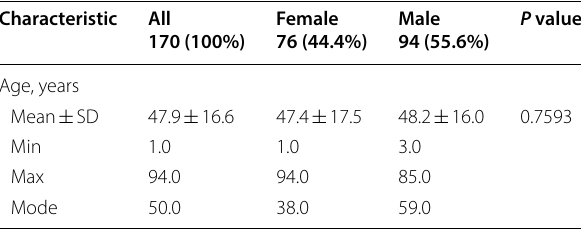
P value is two-sample t test for comparison of mean values between sexes